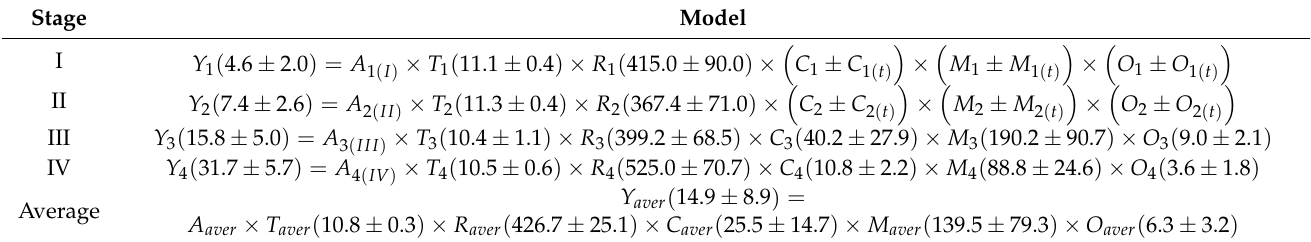
Regression Coefficient R Y